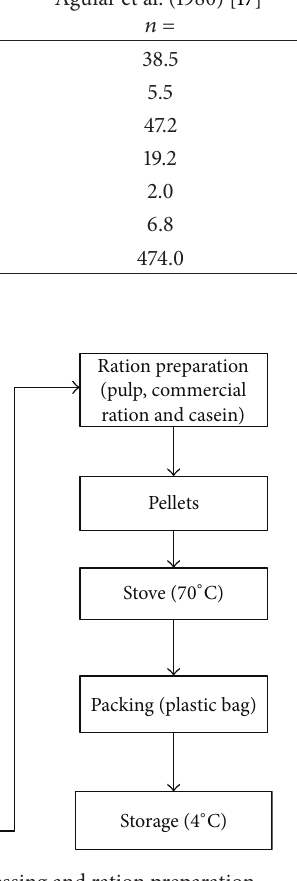
Figure 1: Fruit processing and ration